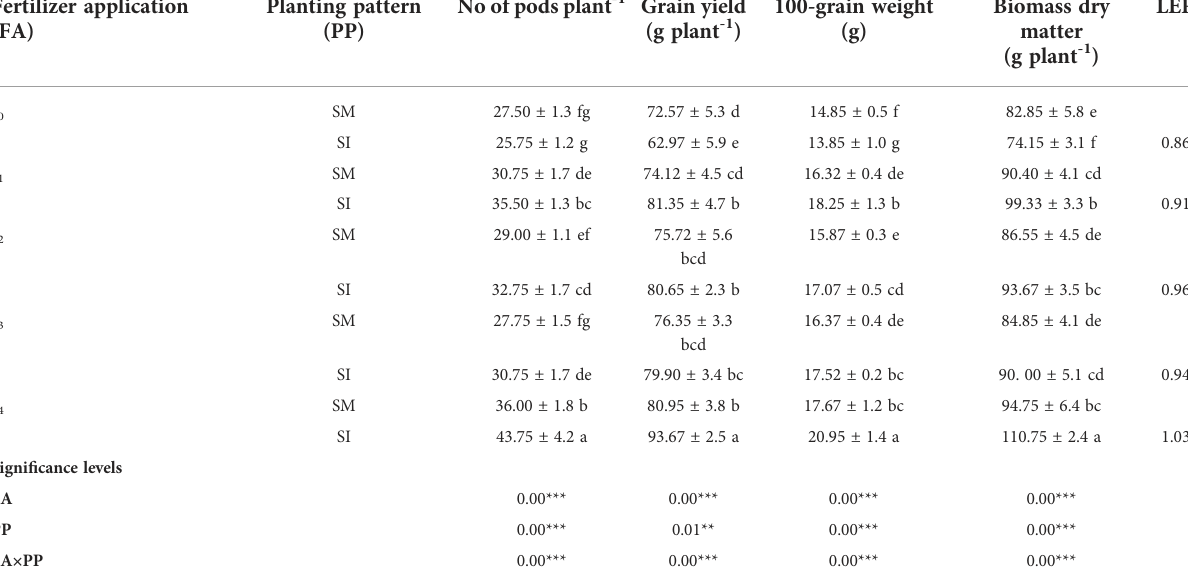
TABLE 2 Yield indices and biomass dry matter of soybean crop as in fl uenced by different fertilizer application and planting patterns. Fertilizer